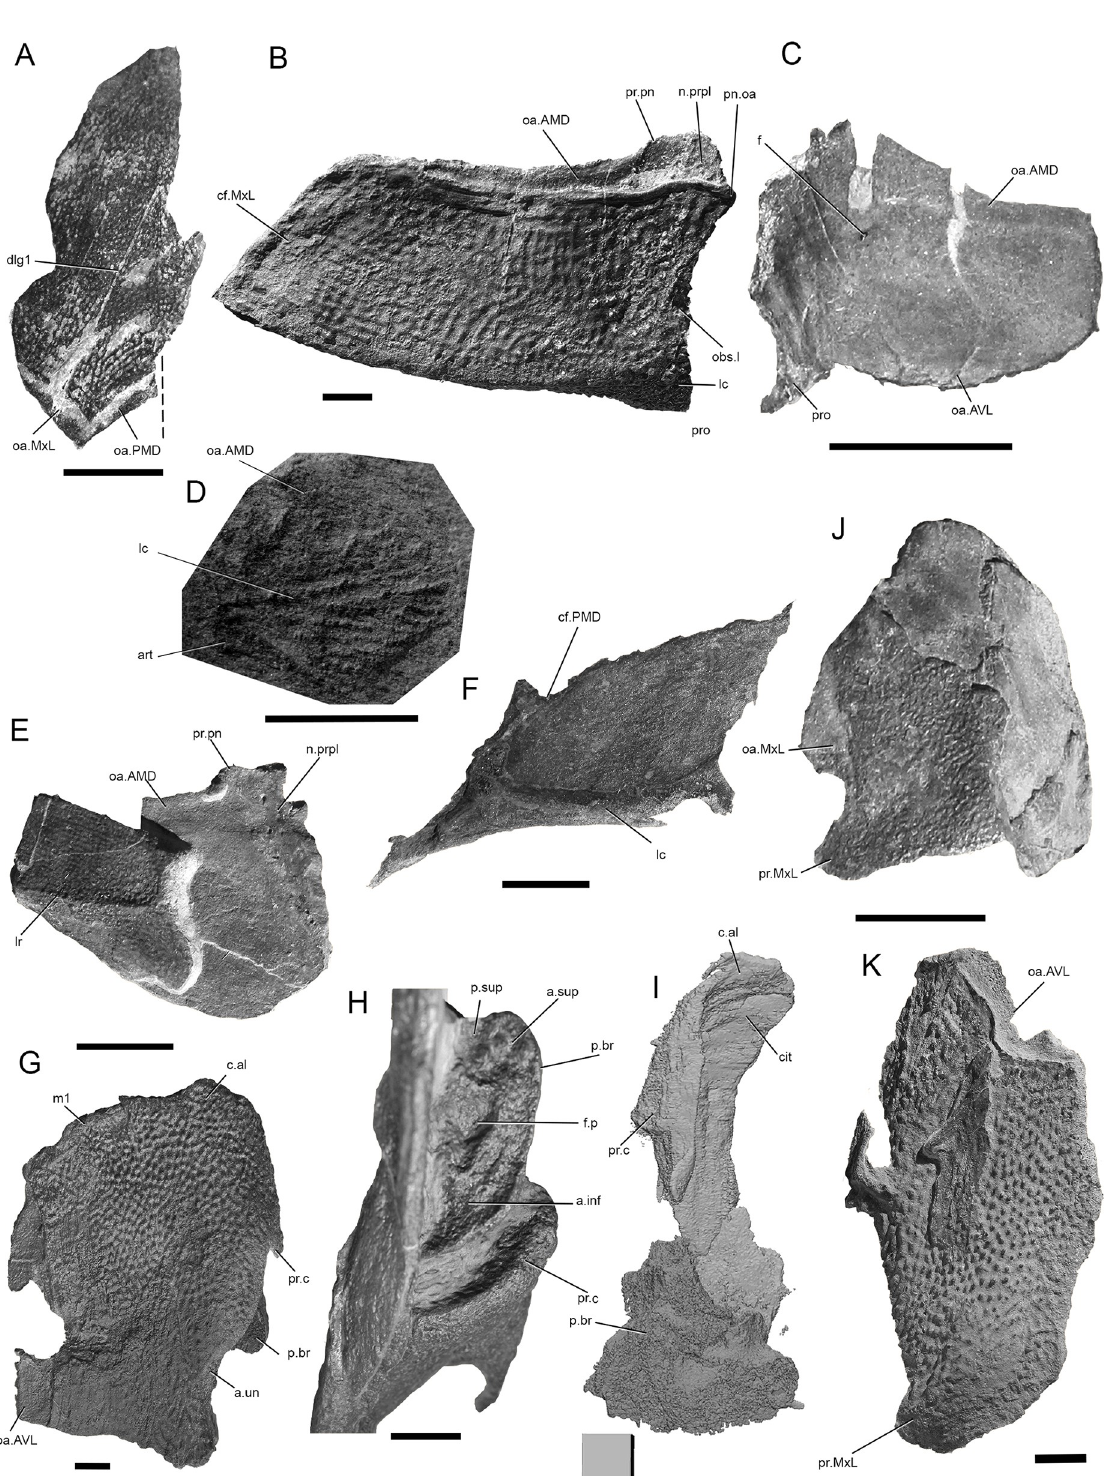
Fig 6. Bothriolepis dairbhrensis sp. nov. Disarticulated elements of the body armour. A. Anterior median dorsal plate in dorsal view, TCD 19618-FB1xxx (no precise number registered). B. Right anterior dorsolateral plate in external view, NMING:F35208. C. right anterior dorsolateral plate in internal view, NMING:F35209. D. Left anterior dorsolateral plate of a very young individual (NMING:F35210). E. Right anterior dorsolateral plate in external and internal views, NMING:F35211. F. Right mixilateral plate in internal view, NMING:F35212. G-H. Left anterior ventrolateral plate, NMING:F35213 (F in ventral external view, G focus on the brachial process). I. Left anterior ventrolateral